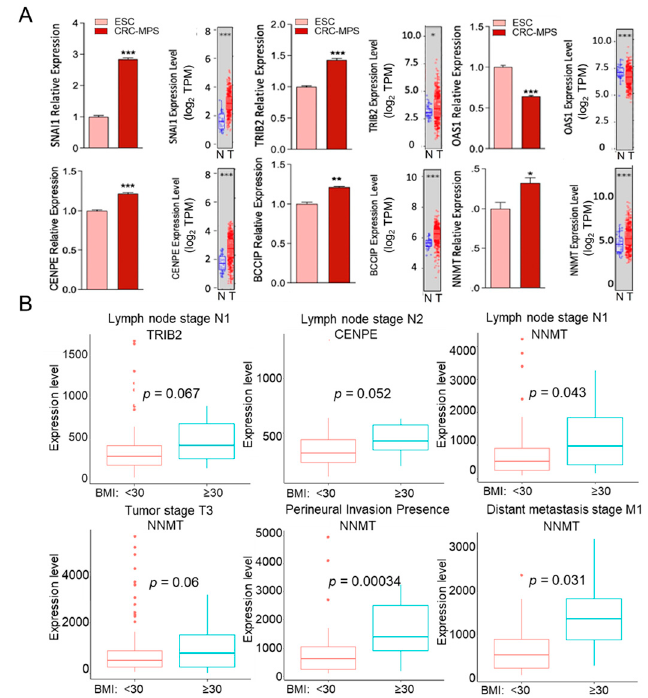
Figure 4. ( A ) Validation of DEGs in HT29 cells treated with CM from CRC-MPS (obese) and ESC (24 h) by qPCR. The following transcripts were assessed: SNAI1, TRIB2, OAS1, CENPE, BCCIP, and NNMT (qPCR, n = 3, * p < 0.05, ** p < 0.01, *** p < 0.001). Similar significant alterations of these transcripts were found in colon cancer patient tissue (grey box plots) (TCGA: normal colon ( n = 41) and tumors ( n = 457)). ( B ) Transcriptomic data of samples from colon cancer patients that included both weight and height information (TCGA) were further classified by BMI (obese: BMI > 30, n = 84, and non-obese: BMI < 30, n = 198). Selected genes were analyzed for expression levels (log 2 TPM) in various clinical cancer stage subsets associated with tumor dissemination (Box plots).